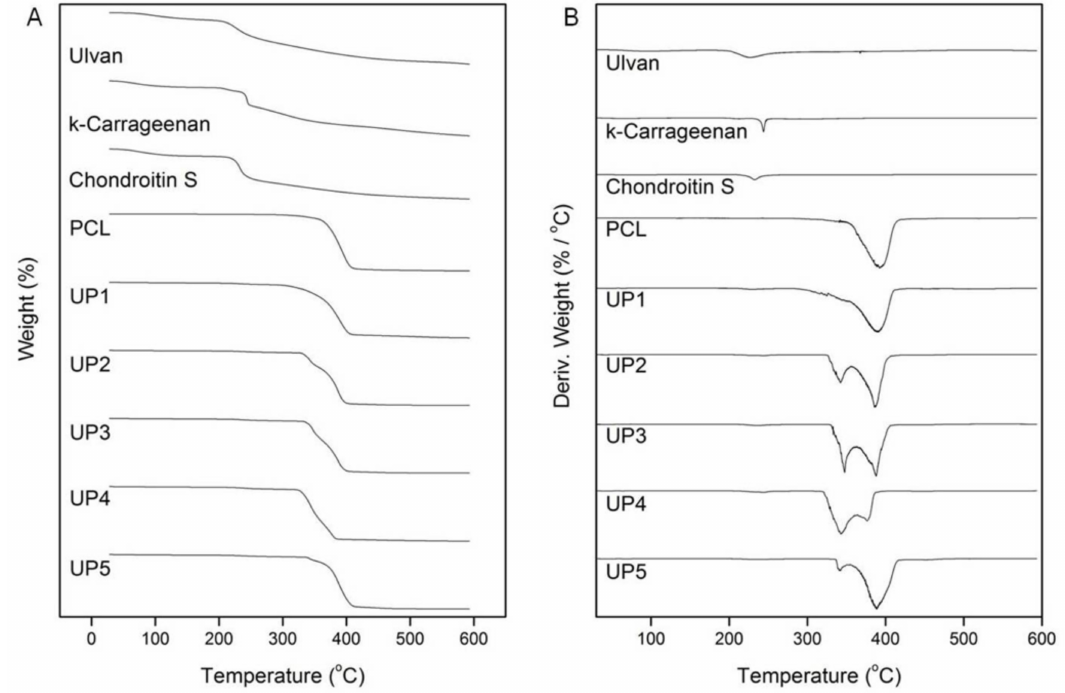
Figure 4. ( A ) TGA and ( B ) DTG thermograms of ulvan, κ -carrageenan, chondroitin sulfate, PCL and UP